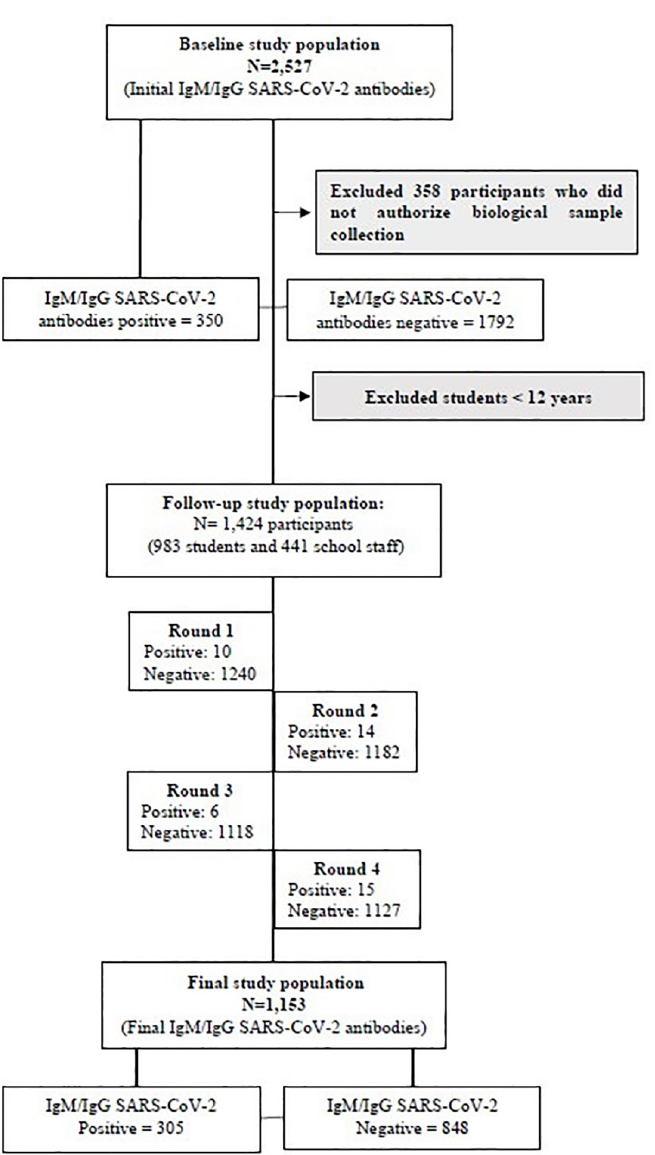
Fig 1. Flowchart of population at cross-sectional and longitudinal prospective components of the